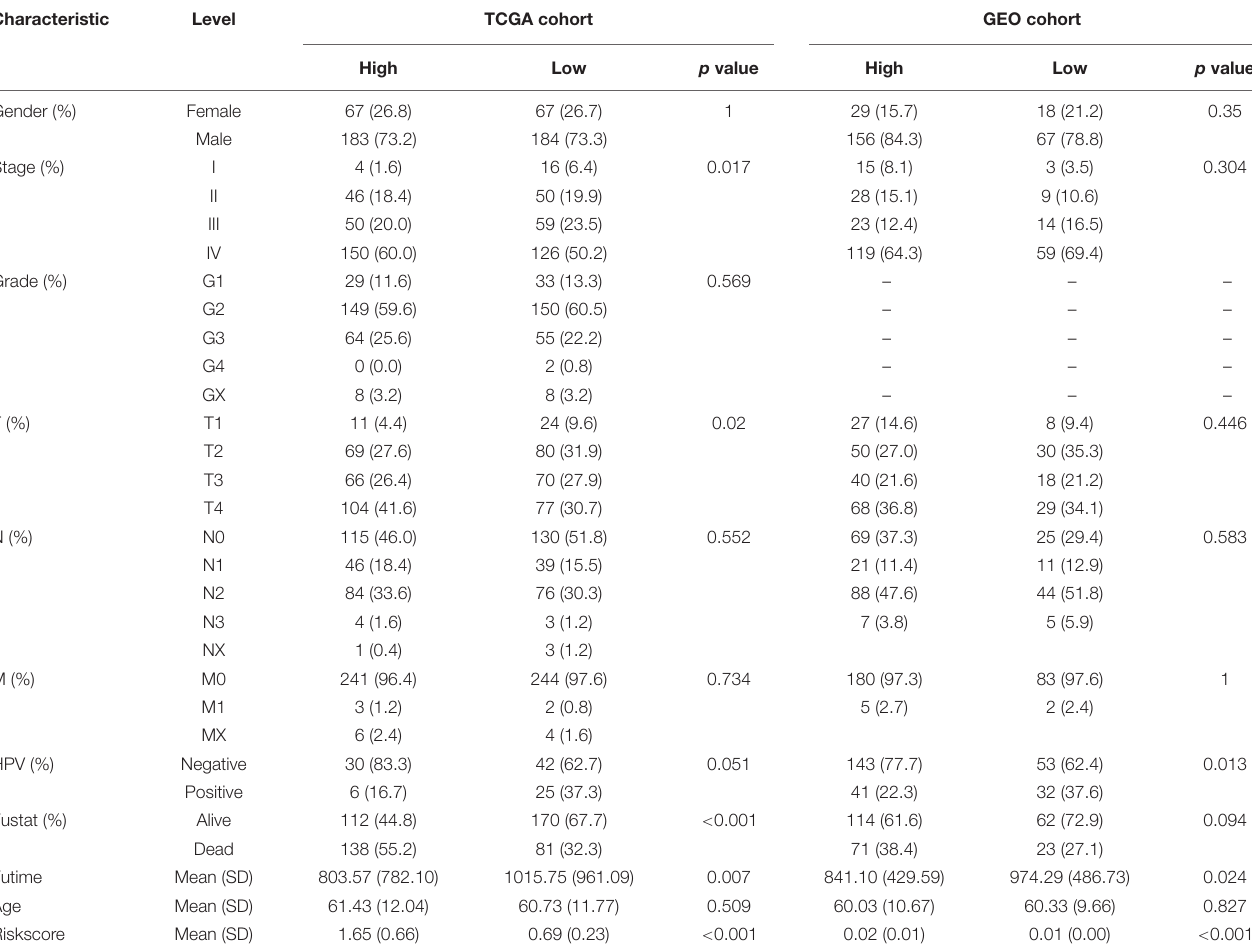
TABLE 3 | Clinical characteristics of HNSCC patients by different CMS groups.